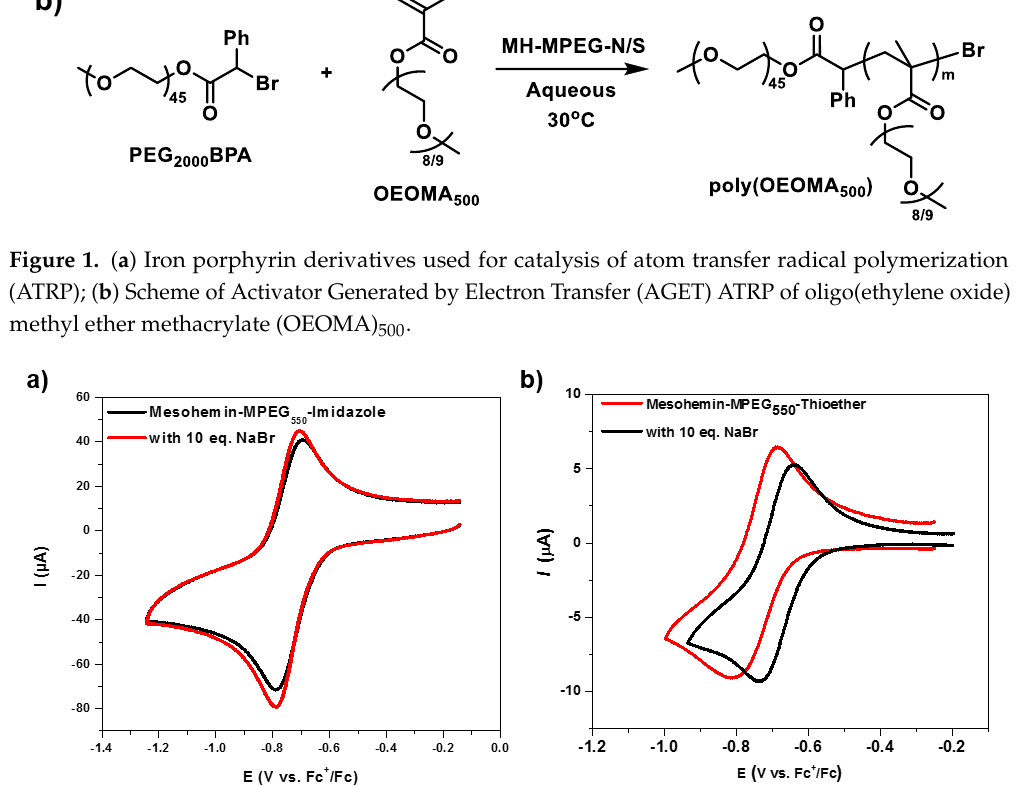
Figure 2. Cyclic voltammogram of ( a ) Mesohemin-methoxy poly(ethylene glycol) (MPEG) 550 -N and ( b ) Mesohemin-MPEG 550 -S, scan rate = 100 mV / s, supporting electrolyte = tetrabutylammonium hexafluorophosphate (TBAPF 6 , 0.1 M in DMF).